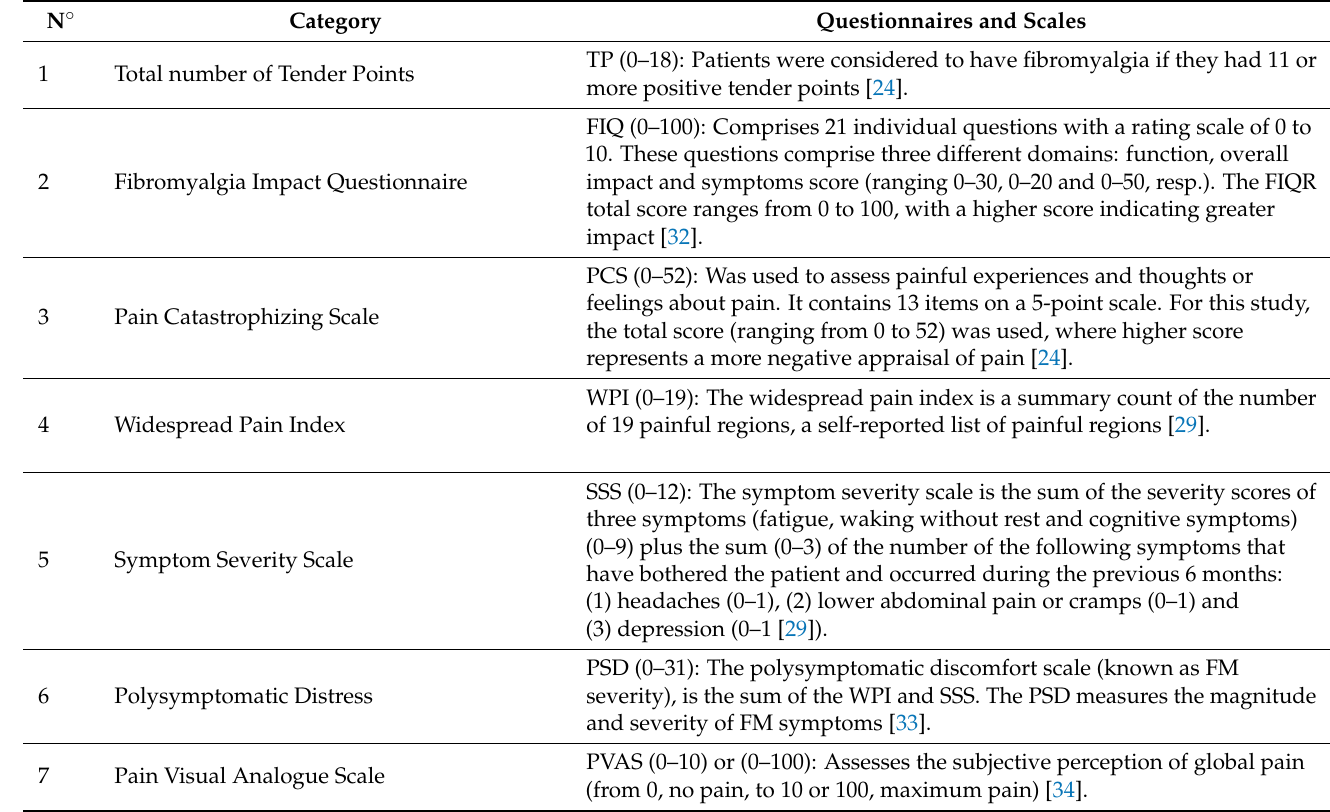
Table 2. Questionnaires and scales used to measure outcomes in selected studies. N ◦ Questionnaires and